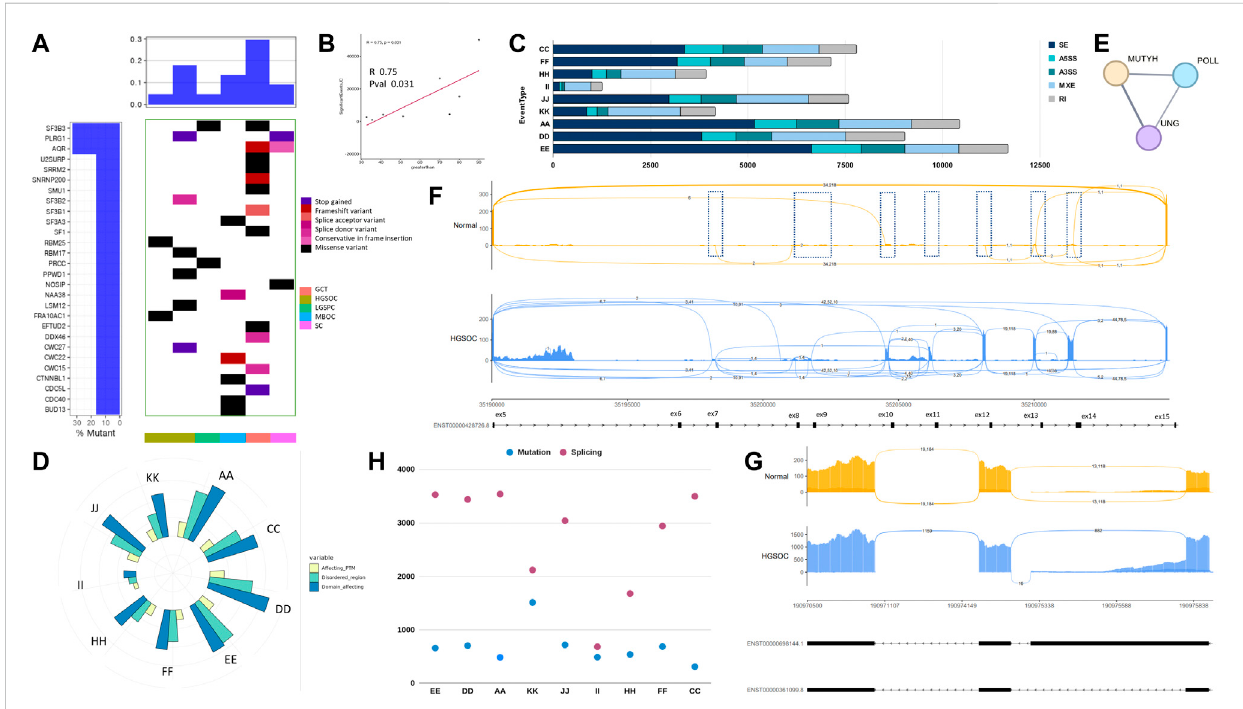
FIGURE 6 Splicing analysis of OVCa histotypes. (A) . Waterfall plot showing mutations in splice factors in patient samples. (B) . Corelation plot of upregulated splice factors and number of alternatively spliced events. (C) . Signi fi cant alternatively spliced events and their abundance in types across samples. (D) . Splice events affected protein domains and modi fi cations mapped from Uniprot in OVCa subtypes. (E) . Active site spice events affecting Base excision repair pathway. (F) . CD44 ex5-ex14 variable region usage in normal and HGSOC samples. Normal samples skip these exons while HGSOCs show variable inclusion events to give rise to oncogenic forms of CD44. Regions indicated in dashed boxes. (G) . STAT1 alternative 3 ′ splice event of a exon in HGSOC harbouring phosphorylated residues involved in signalling. (H) . Number of genes altered by mutation and splicing across